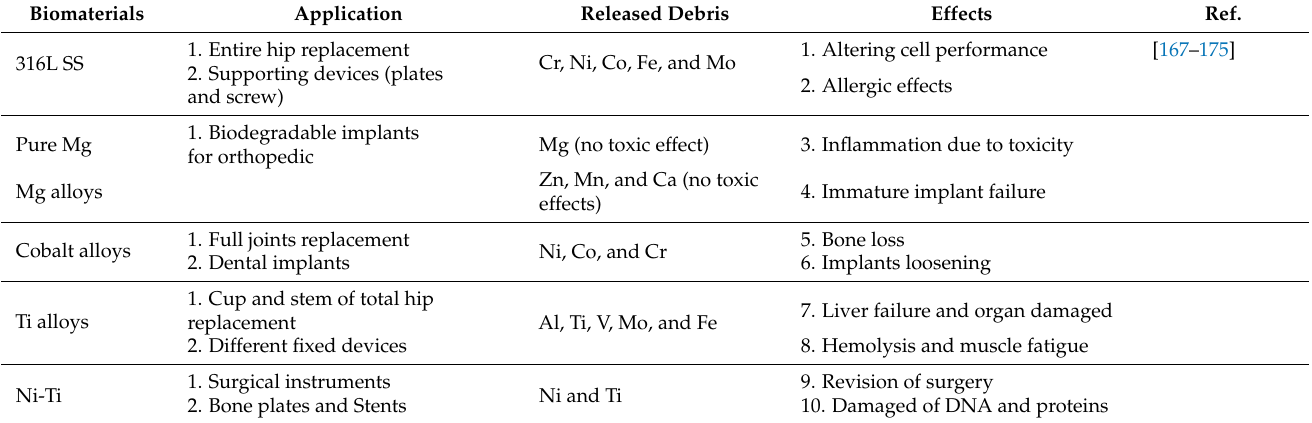
Table 4. Influence of released debris from biomaterials on biological responses during corrosion and wear. Biomaterials Application Released Debris Effects